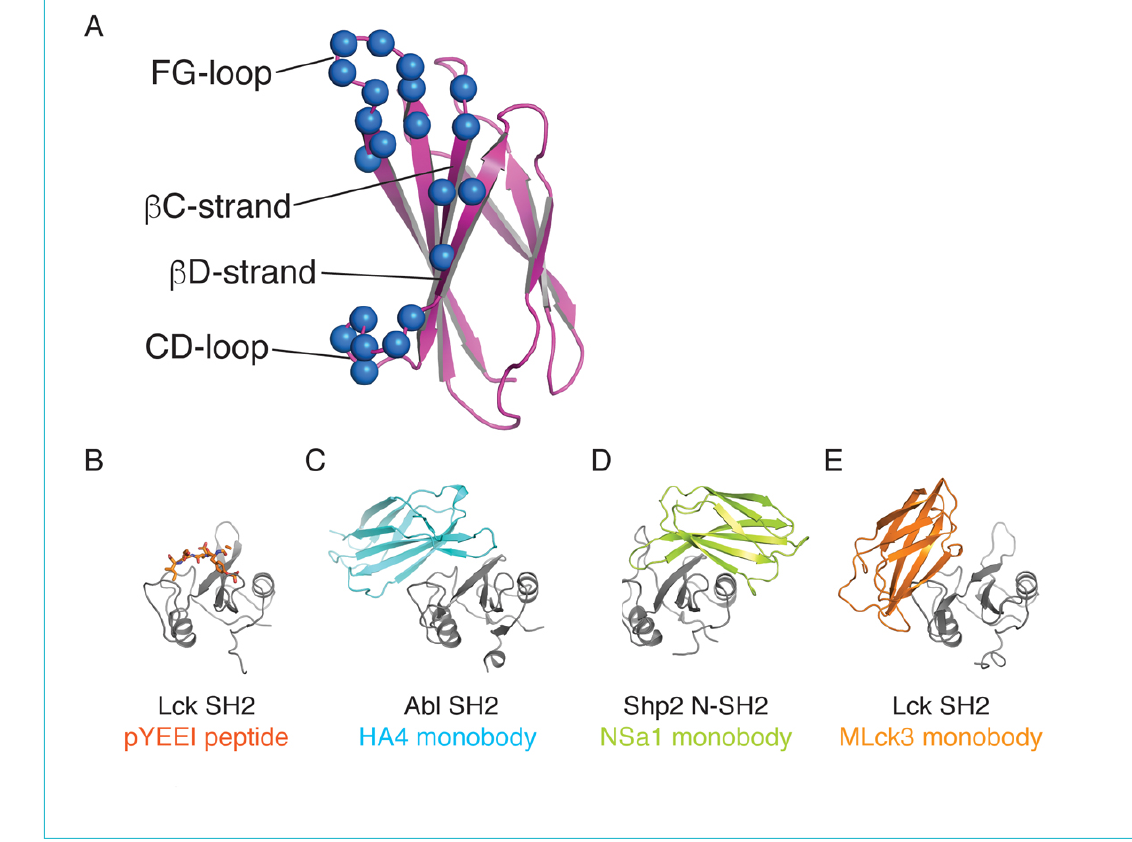
Figure 1: (A) The structure of the FN3 scaffold of a monobody is shown in magenta cartons. The location of the diversified residues in the side-and-loop combinatorial library is shown as blue spheres. (B-E) Co-crystal structures of monobodies targeting three different SH2 domains (panels C, D and E), as well as the pYEEI peptide Lck complex structure (panel B) showing the canonical interaction of an SH2 domain with a phosphotyrosine (pY) peptide, are shown. The SH2 domains are depicted in grey whereas the monobodies and the pYEEI peptide are shown in different colours. The following PDB entries were used to draw this figure: 1LKK (pYEEI peptide-Lck SH2), 3K2M (HA4-Abl SH2), 4JE4 (NSa1-Shp2 N-SH2) and 5MTM (MLck3-Lck